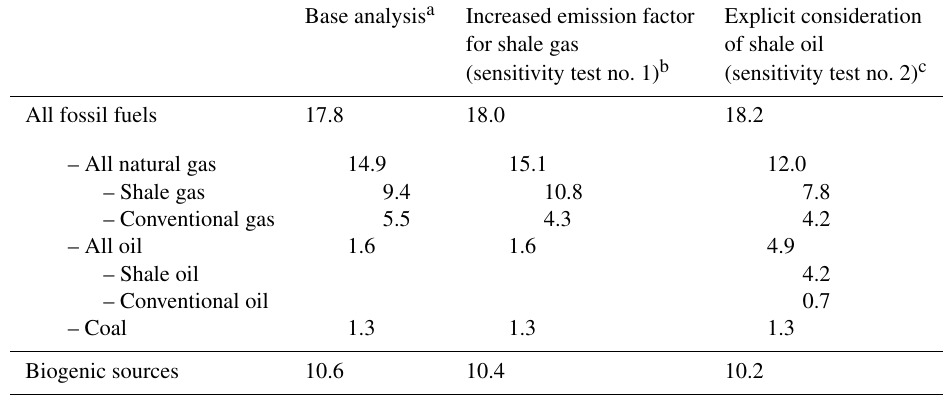
Table 2. Exploration of sensitivity to assumptions for estimates of increase in global methane emissions in recent years (teragrams per